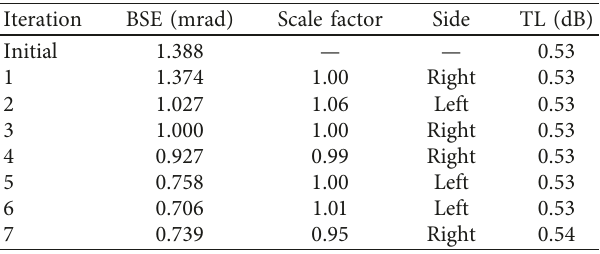
Figure 6: The tangent-ogival radome. Table 1: The maximum BSE during IPD correction iteration.